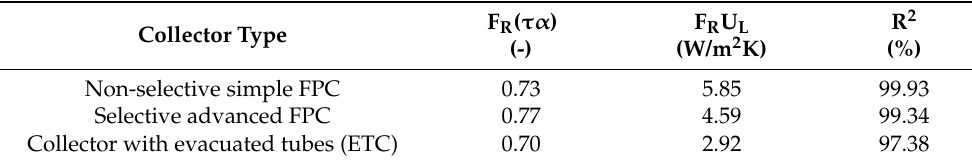
Figure 2. Depiction of the collector efficiency and approximation lines (Analysis for T am = 25 °C and G T = 1000 W/m 2 ). Table 2. Thermal efficiency parameters of the collectors after the